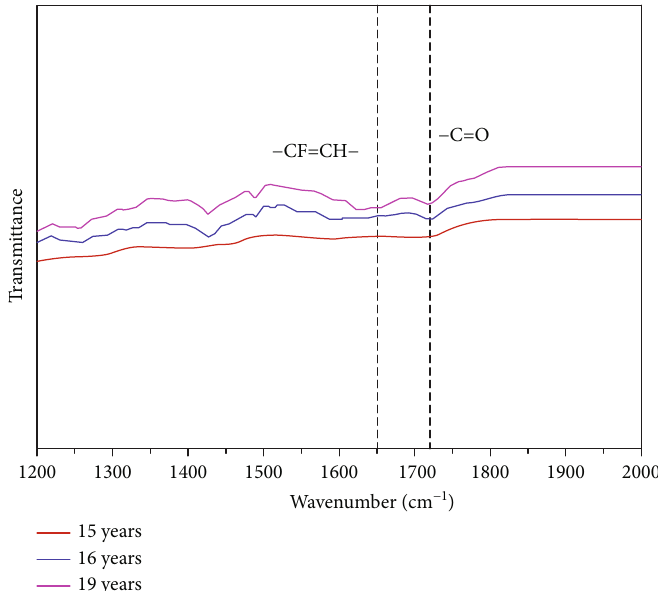
Figure 9: FTIR spectra in the region of 1200-2000cm − 1 for the exposed surface of specimens during service time (15 years, 16 years, and 19 years).